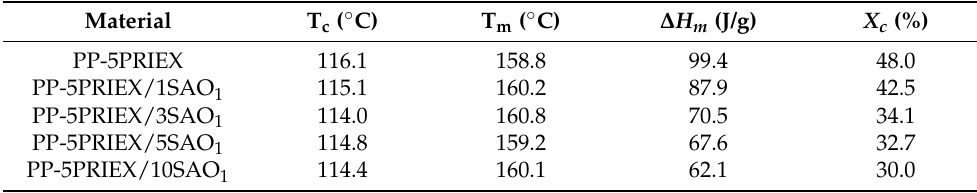
Table 1. DSC data on PP/5PRIEX / SAO 1 composites .